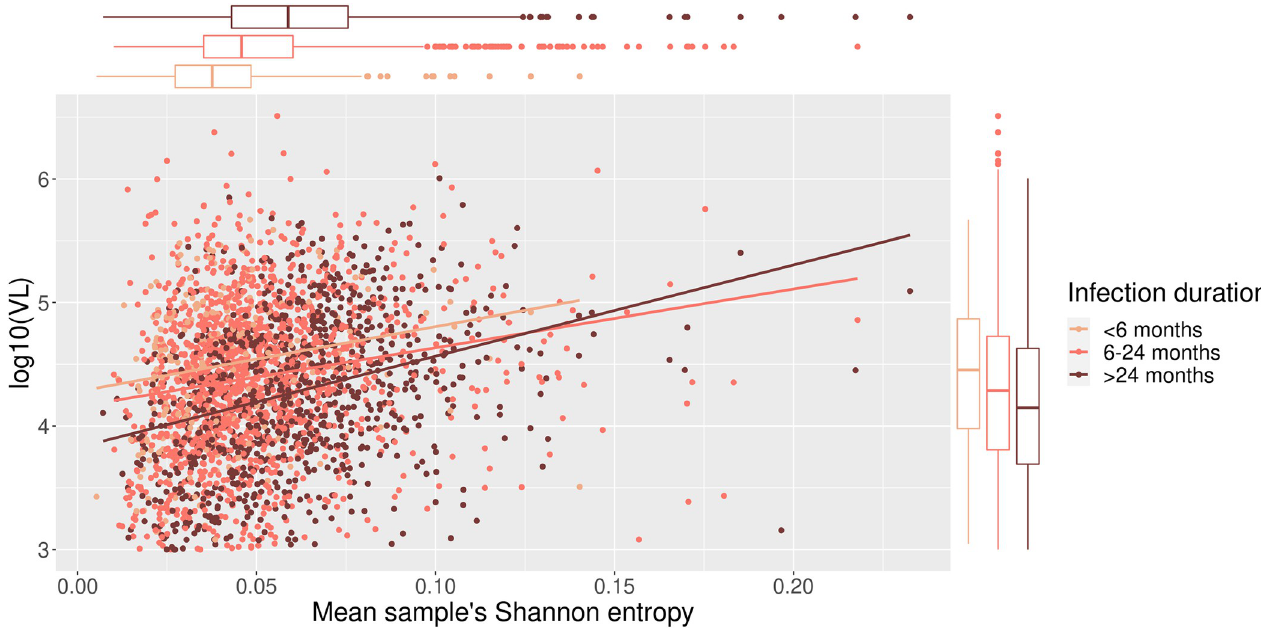
Fig 2. The relationship between sample’s mean Shannon entropy, viral load (VL) and infection duration.